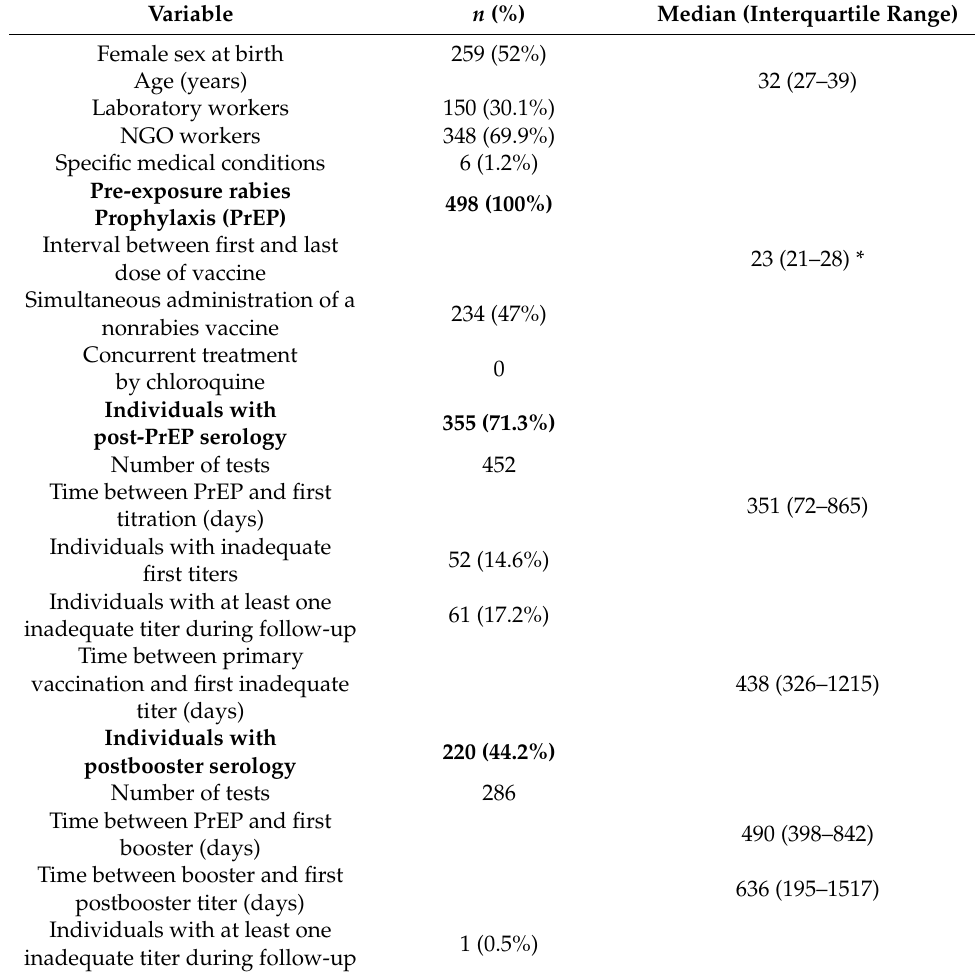
Table 1. Characteristics of the study population ( n = 498), Institut Pasteur, Paris